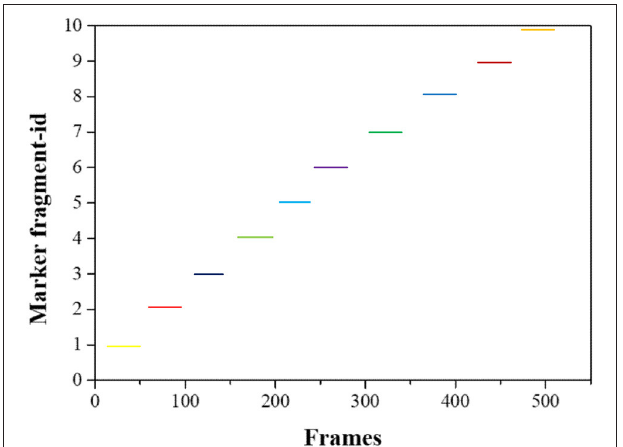
FIGURE 6 | Marked segment after pre-processing.